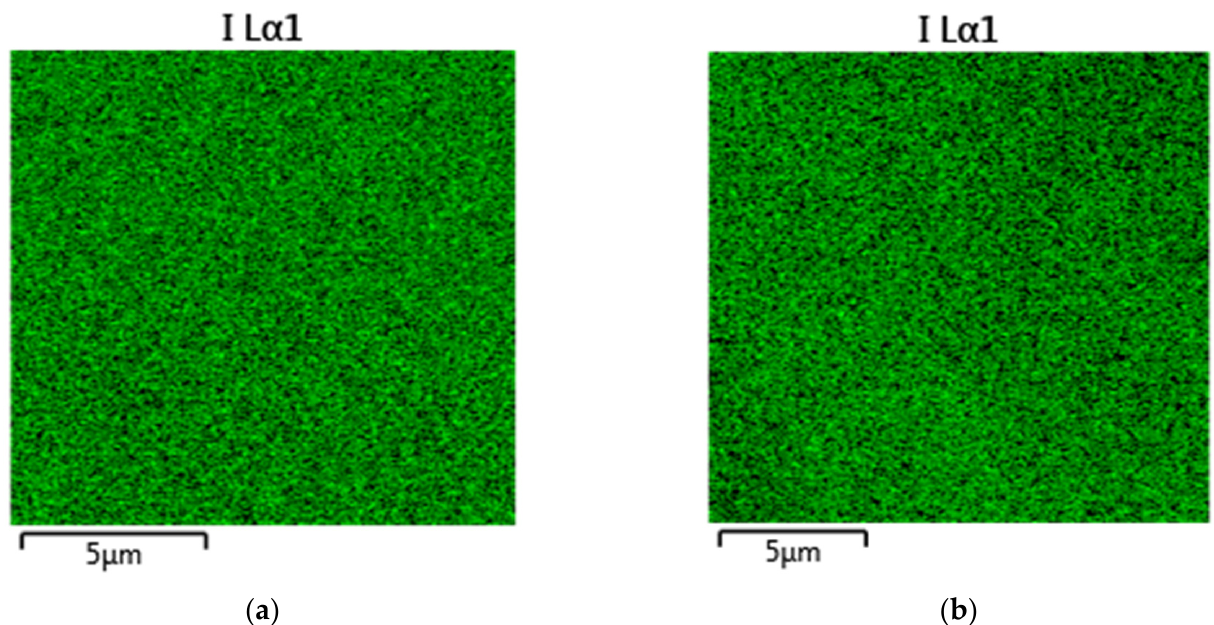
Figure 7. EDX mapping of RF_ac ( a ) and RMF-GO ( b ).